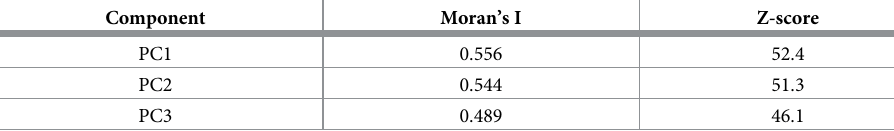
Table 2. Global Moran’s I measure of spatial autocorrelation for each principal